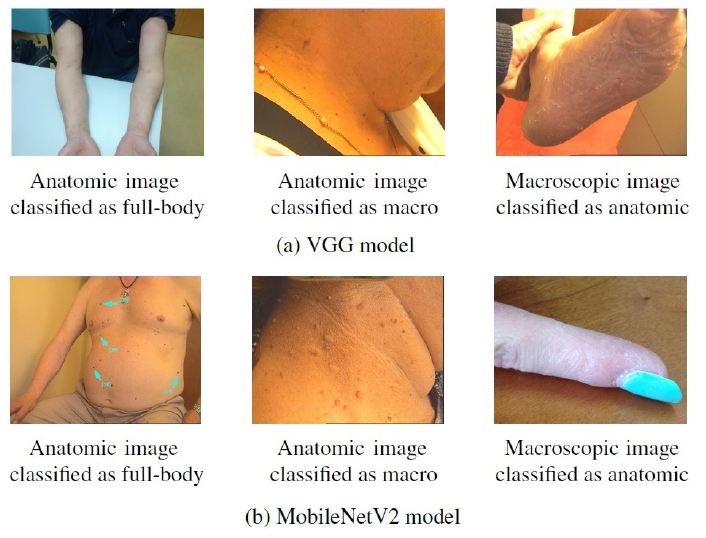
Figure 7. Examples of images from Task A correctly classified after the first training but misclassified after the incremental